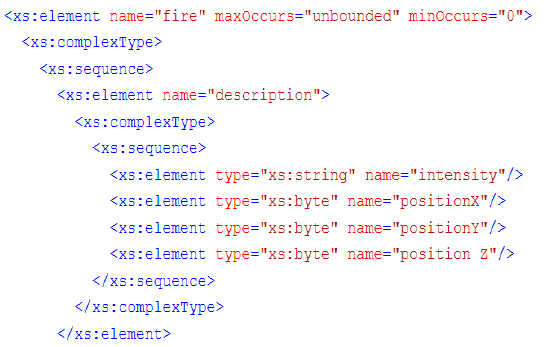
Figure 12. XML file containing a fire description.